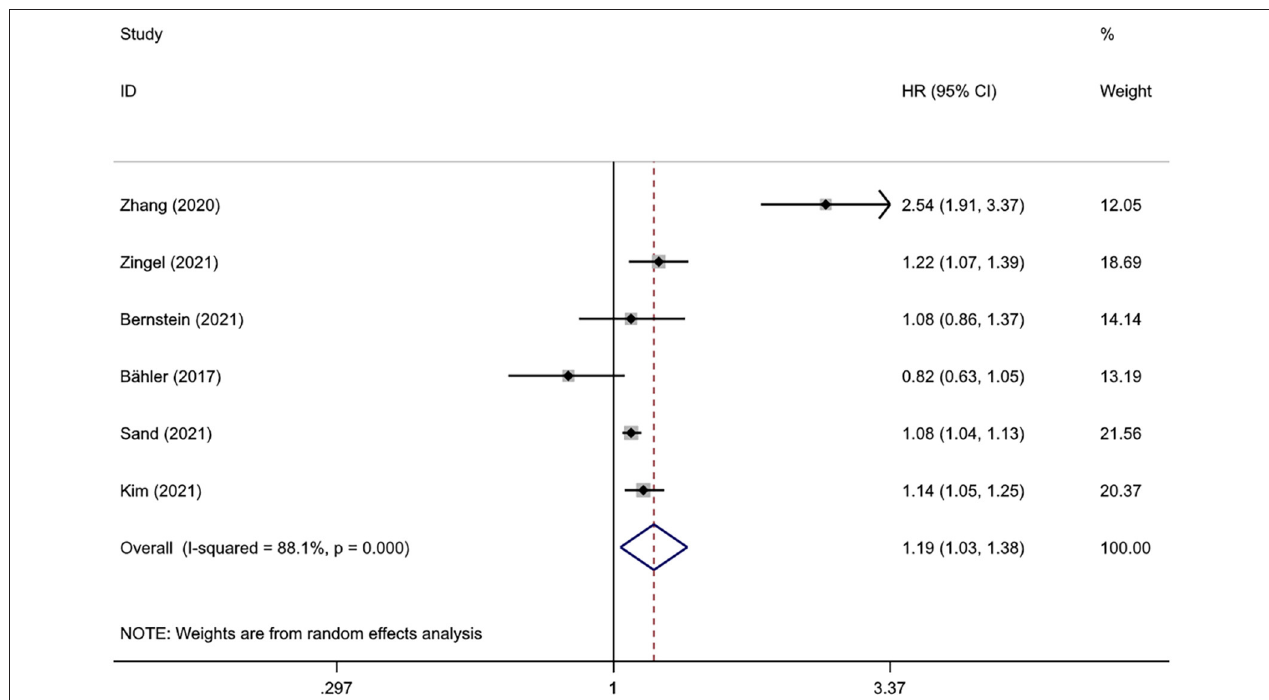
FIGURE 2 | The overall association between inflammatory bowel disease and